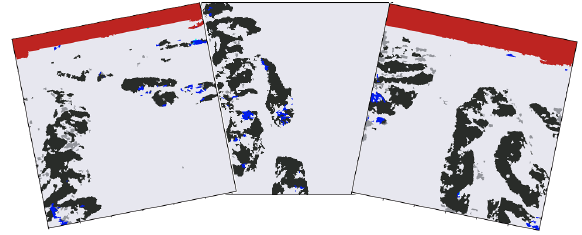
Figure 7. Semantic segmentation of the triplet from figure